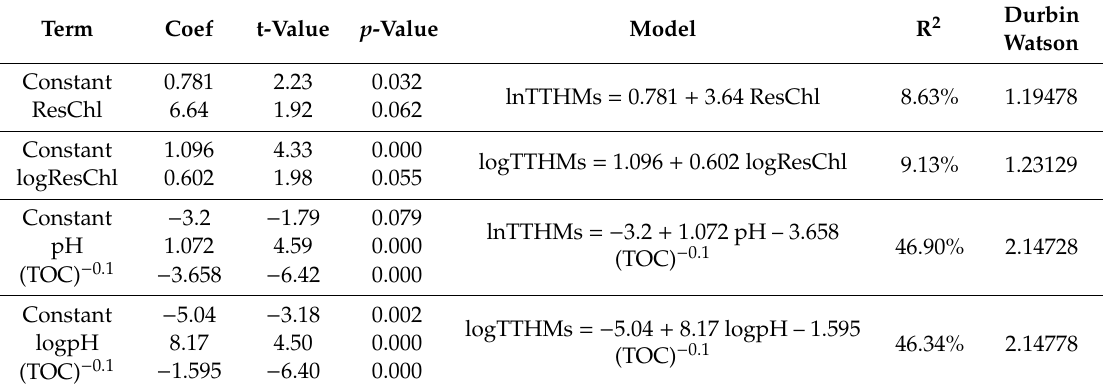
Table 5. Statistical analysis data for the 4 models developed for WDN A and WDN